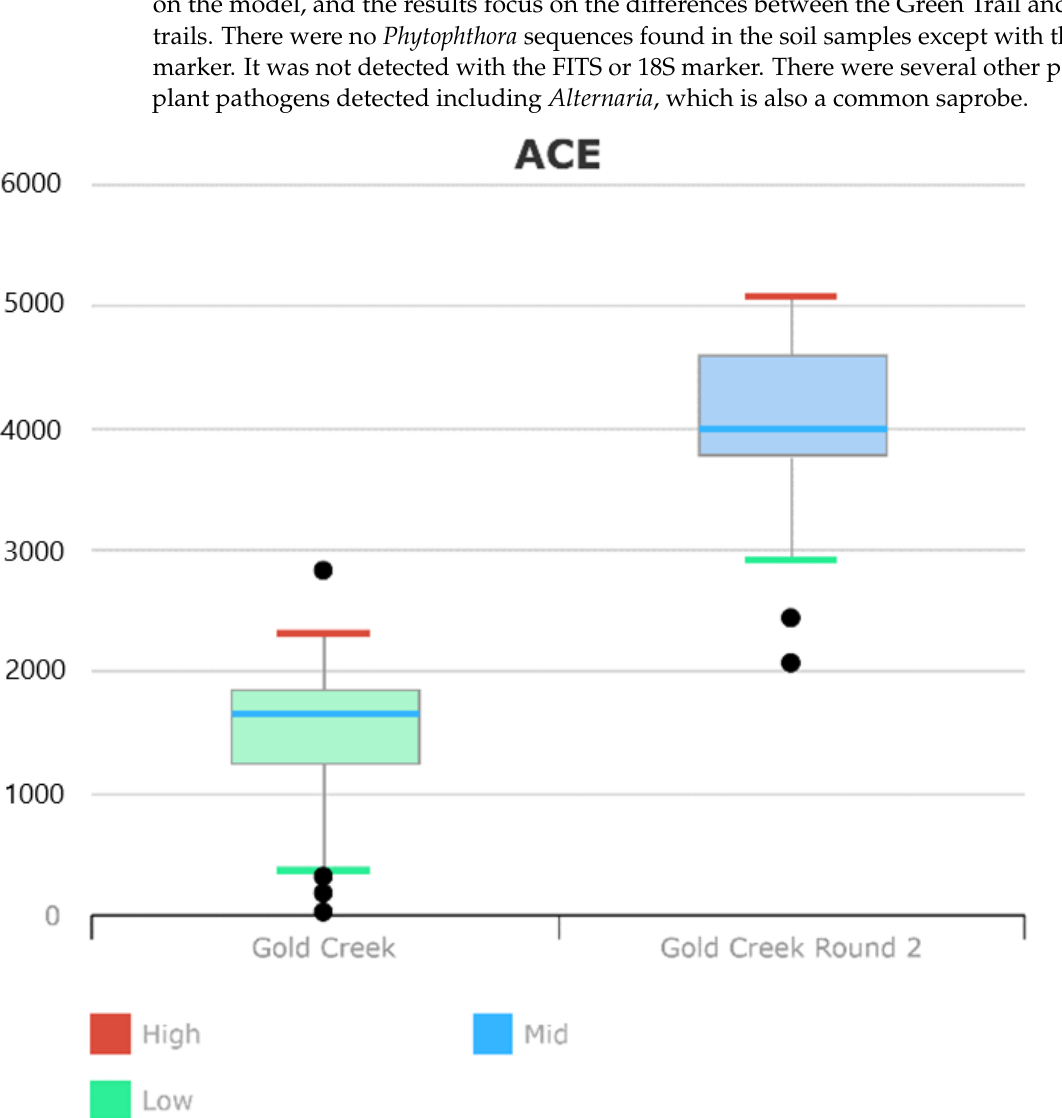
Figure 6. Alpha Diversity Index for the winter versus the summer samples. Note evidence of overdispersion since both groups show